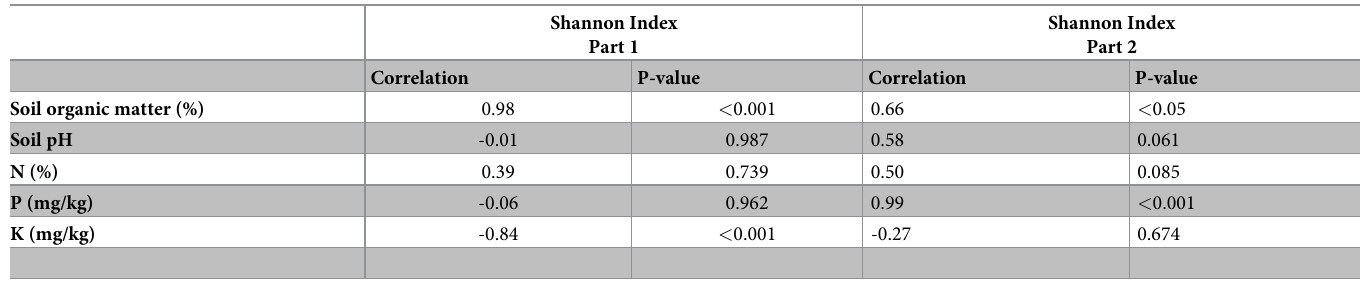
Table 5. The correlation between Shannon Index value and soil variables.